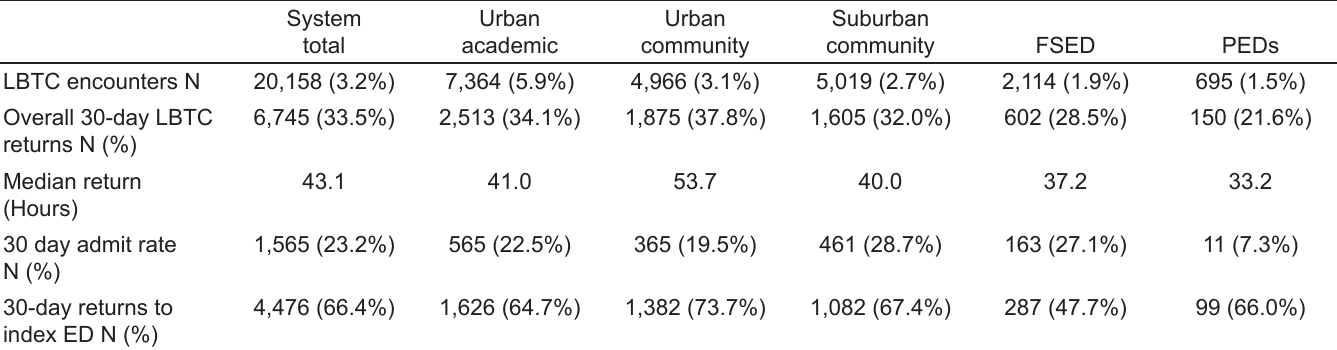
Table 1. Left before treatment complete (return encounter characteristics for the healthcare system and based on hospital type).